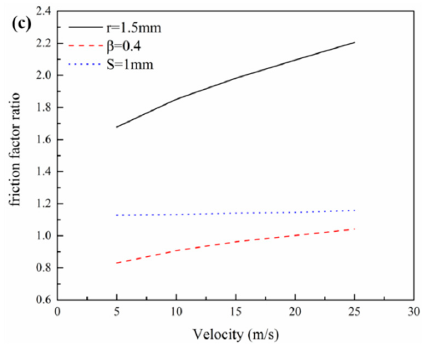
Figure 12. Friction factor ratio versus the inlet velocity for three kinds of wavy fin with ( a ) γ = 0.38; ( b ) γ = 0.42; ( c ) γ = 0.45.